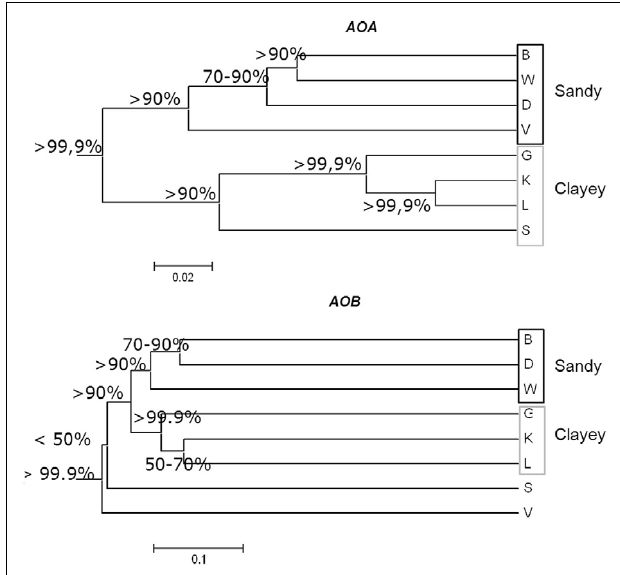
FIGURE 5 | Dendrogram based onAOA (A) andAOB (B) amo A clone libraries, showing the differences in the community structure from eight soils. Distance matrices generated with UniFrac were used to cluster the soils using UPGMA; and jackknife analysis was used to evaluate how robust each environment cluster is to sample size and evenness. Numbers indicate the frequency with which nodes were supported by jackknife